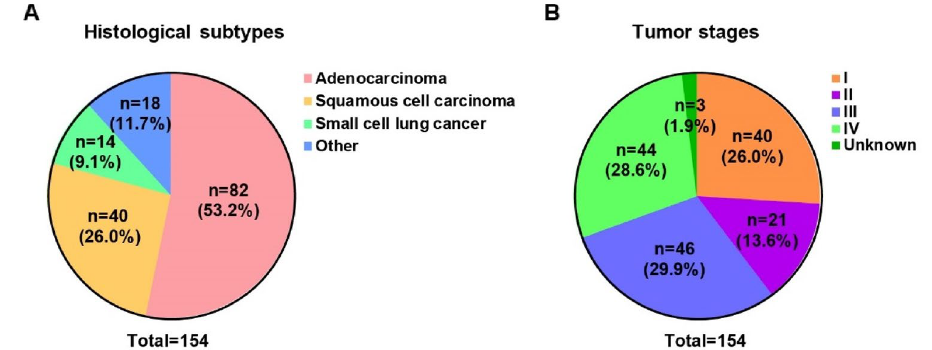
Figure 2. Histological subtypes ( A ) and tumor stages ( B ) of the patient